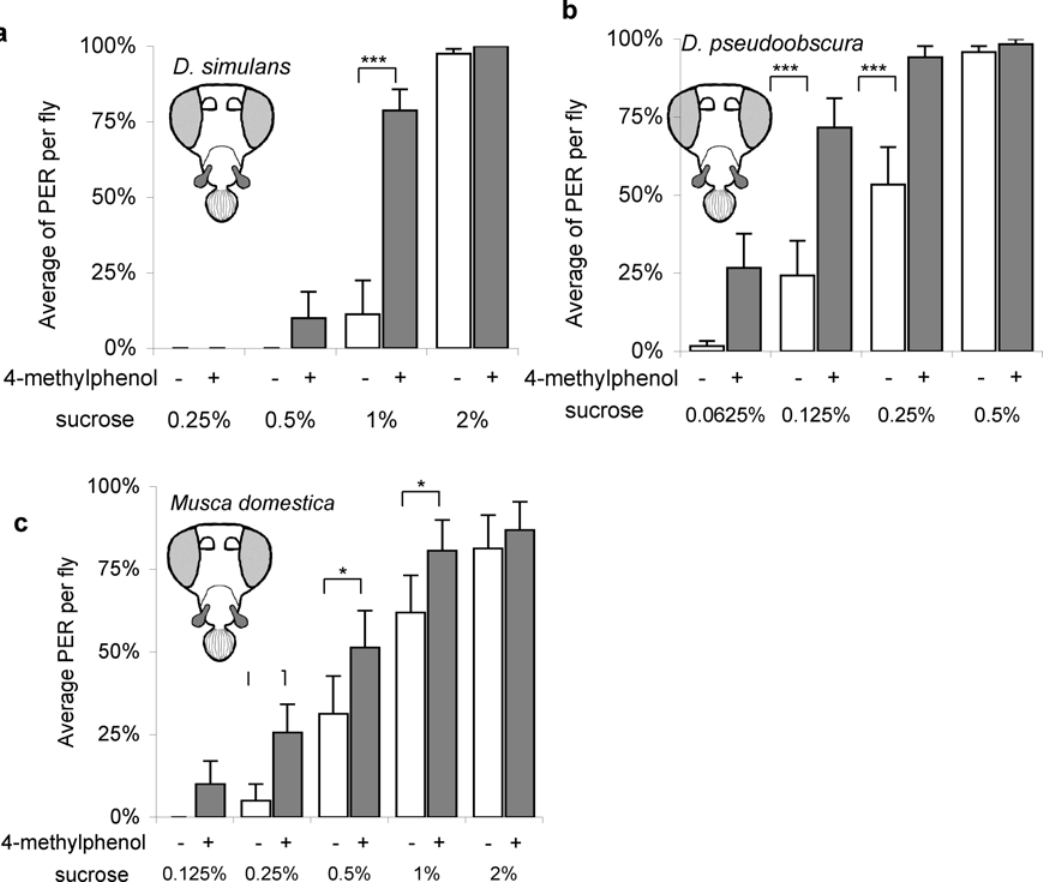
Figure 6. Taste enhancement in a) D.simulans , b) D.pseudoobscura , c) Muscadomestica , all without antenna (Ant 2 , MP + ). n=7 to 14